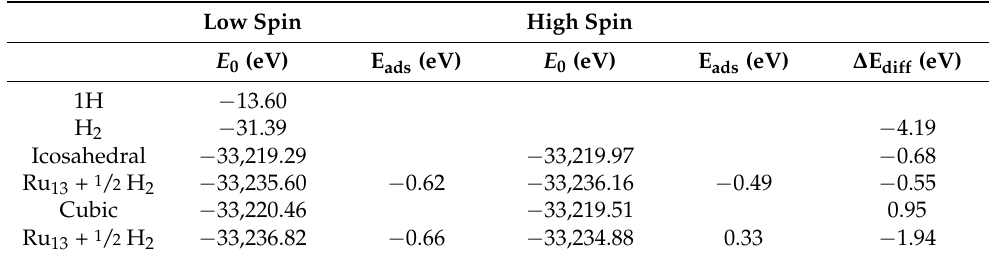
Table 5. System energy ( E 0 ), adsorption energy (E ads ) and energy difference ( ∆ E diff ) for the fcc Ru icosahedral and cubic nano-dots of two sizes with H-adsorption onto the fcc hollow site to include the high and low spin contributions with Gaussian-09 (with the PBE functional [40,41] in combination with the LANL2DZ doublet zeta ( ζ ) basis set